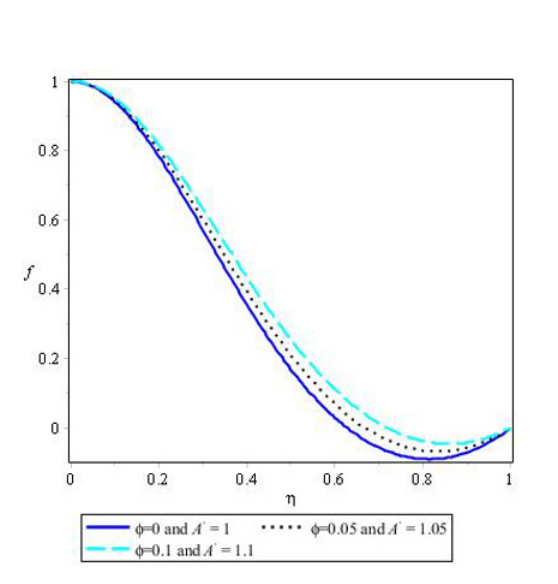
Figure 22. f ( η ) for different values of φ and A ∗ ( Ha = 0 , Re = 200 , Ha = 0 , α = 5 ◦ ).